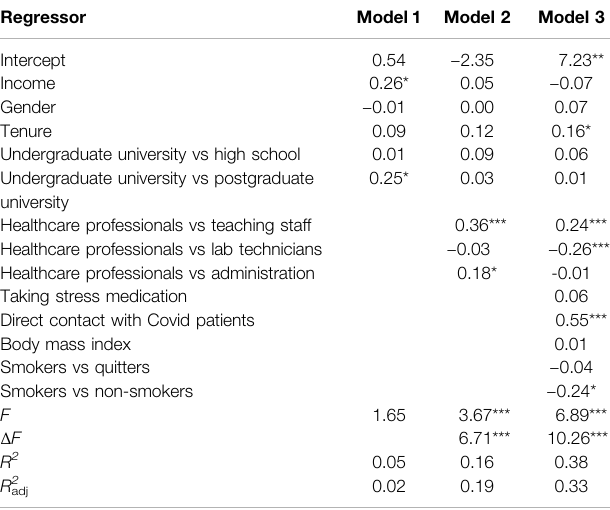
TABLE 4 | Regression model for